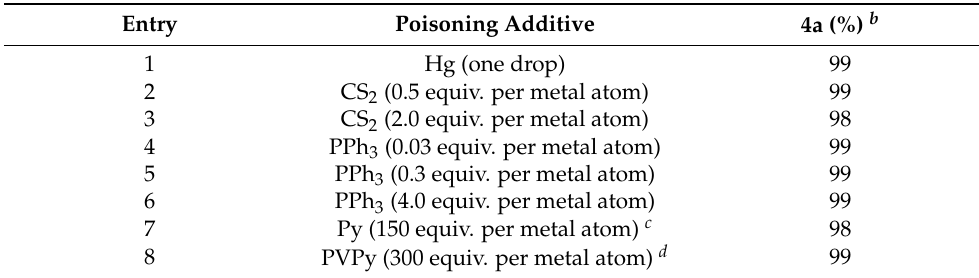
Table 1. Summary of poisoning experiments a